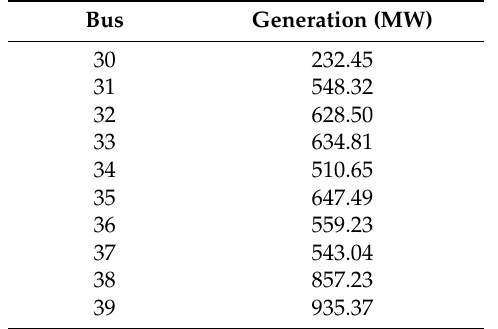
Table 2. Quantities of generation in the basic case without any violation of constraints obtained from the OPF method.